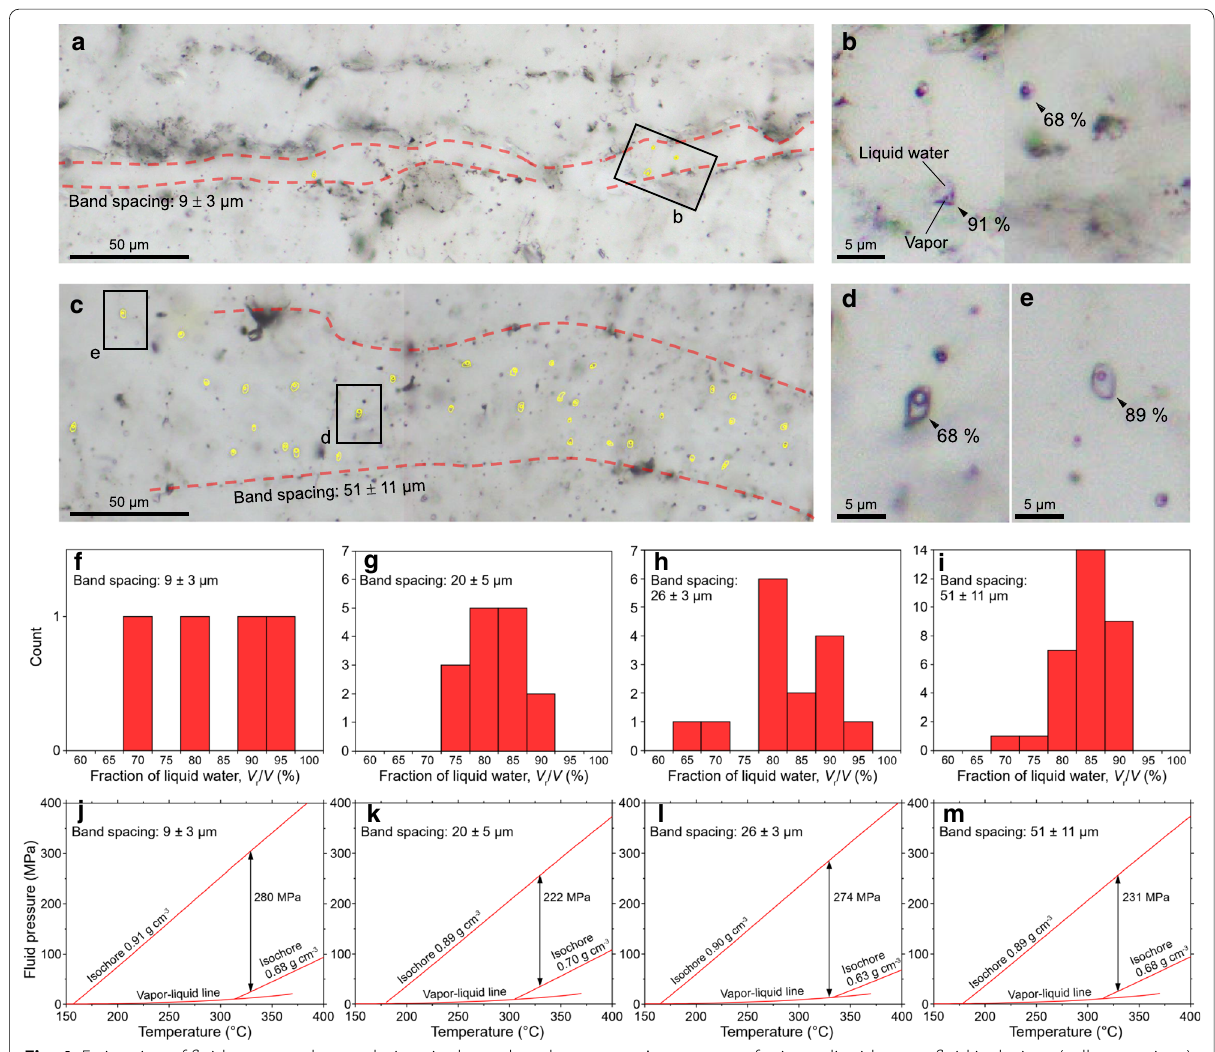
Fig. 4 Estimation of fluid pressure change during single crack-seal event. a , c Appearance of primary liquid–vapor fluid inclusions (yellow portions) between inclusion bands under plane-polarized light. Dashed red lines indicate phyllosilicate inclusion bands. b , d , e Closeup of fluid inclusions, showing various vapor/liquid ratios. Locations of images are shown in ( a and c ). The area fractions of liquid water in fluid inclusion are shown. f – i Measured vapor/liquid ratios of primary fluid inclusions trapped during single crack-seal event for various inclusion band spacings. j – m Fluid pressure drop during single crack-seal event estimated from the vapor/liquid